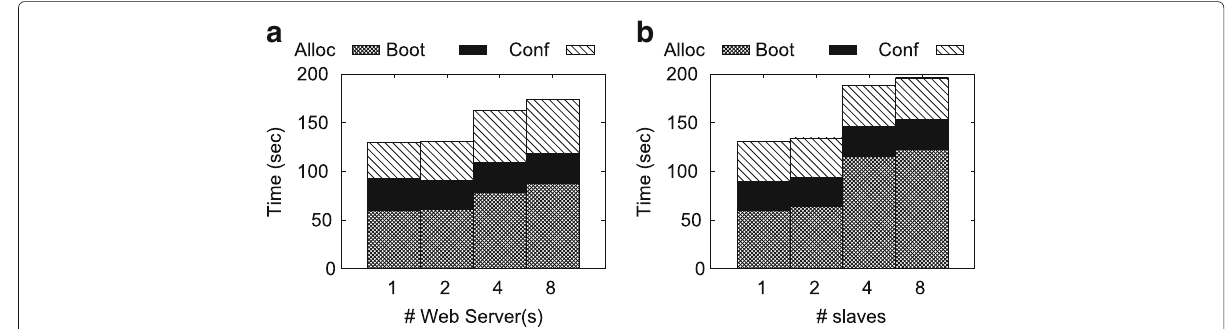
Fig. 8 Execution times of different deployment phases for varying module multiplicity using prebaked images. a Wordpress. b Hadoop